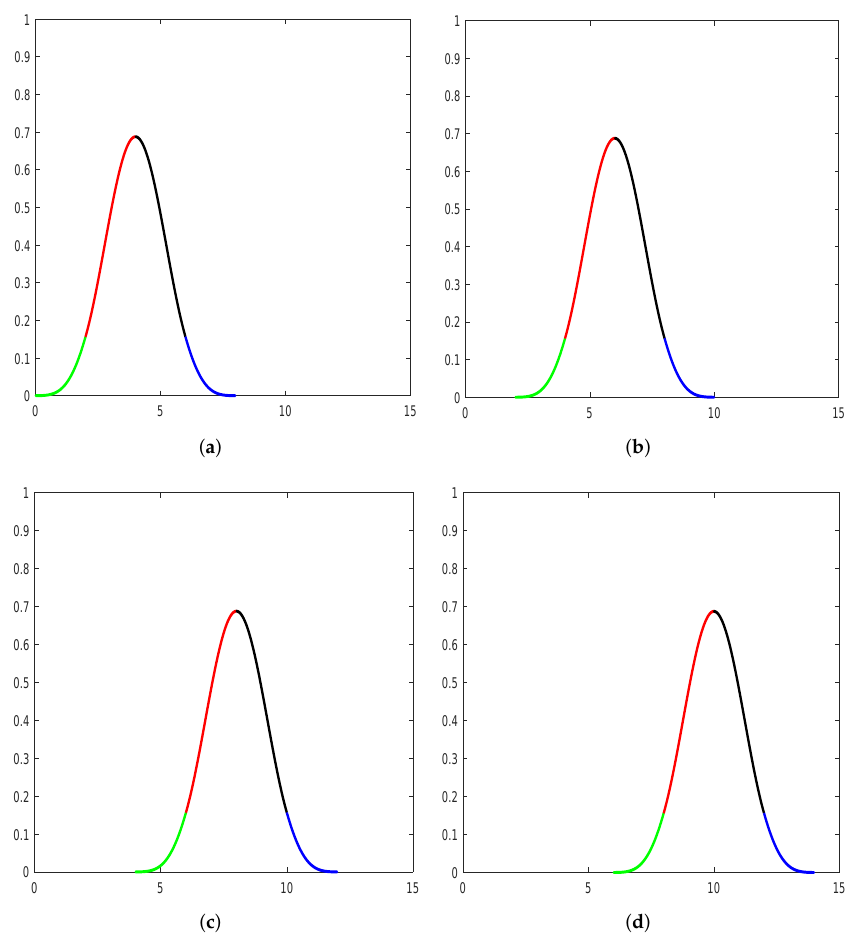
Figure 1. Cubic TBFs curves. ( a ) λ ∈ [ 0,8 ) , ( b ) λ ∈ [ 2,10 ) , ( c ) λ ∈ [ 4,12 ) and ( d ) λ ∈ [ 6,14 ) .